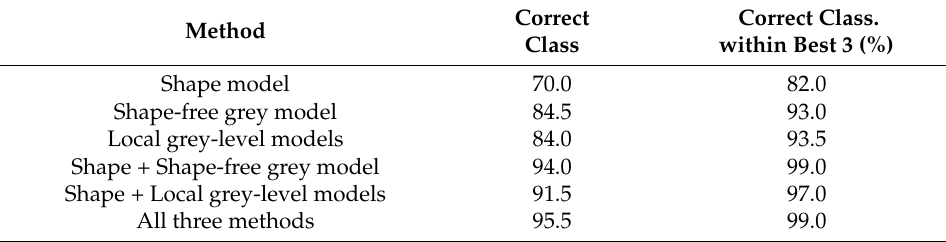
Table 2. Results for the initial face identification experiments by A. Lanitis, C. J. Taylor and T. F. Cootes.